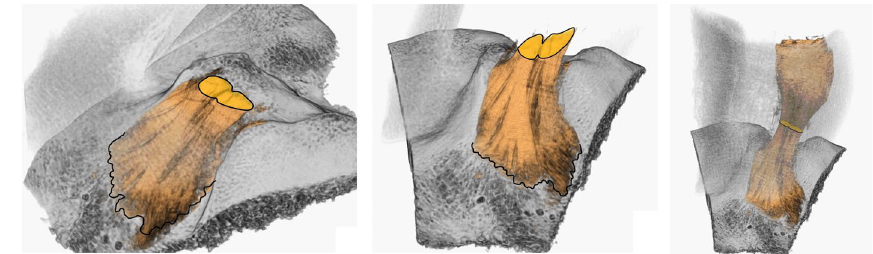
Fig. 2 3D-CT of the tibial insertion of a human ACL